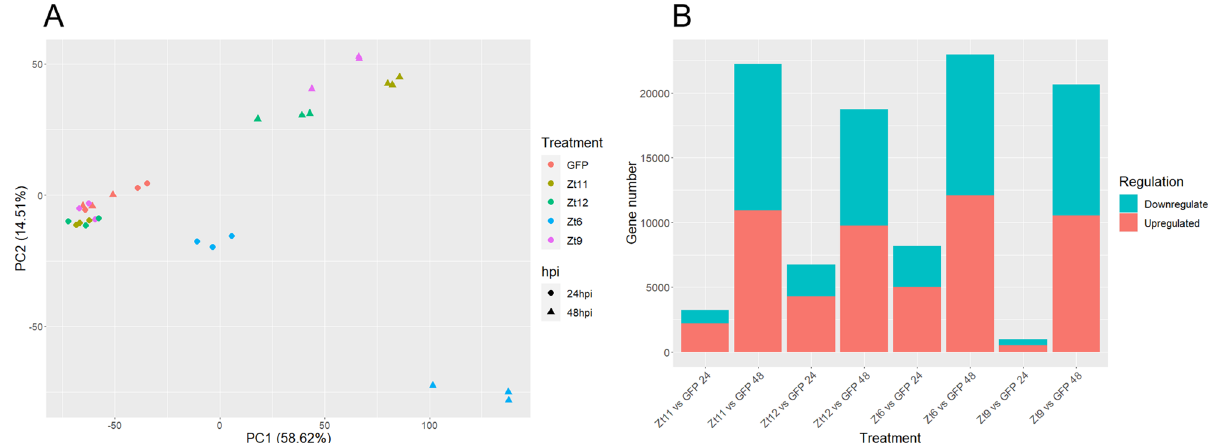
Figure 1. ( A ) PCA plot of RNA-seq data. SSP treatments and timepoints indicated. ( B ) Total numbers of upregulated (red) and downregulated (blue)